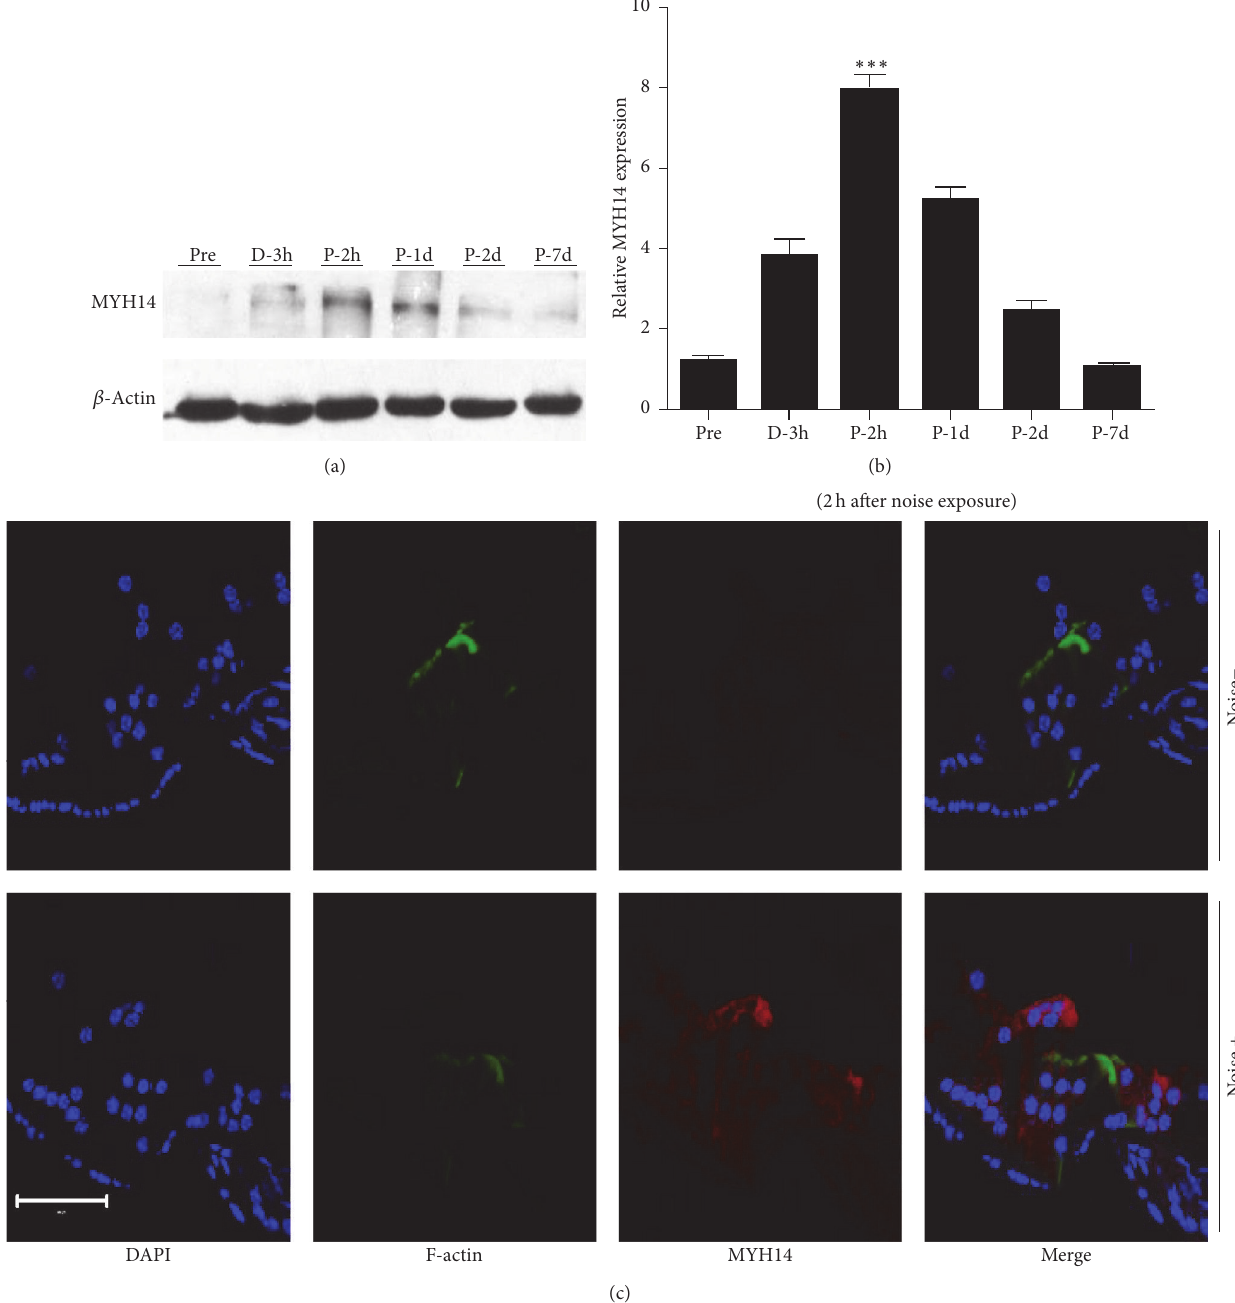
Figure 7: Expression of MYH14 is noise exposure-dependent. ((a) and (b)) Western blots analysis was performed at different time points (before, during, and after noise exposure) to show the expression levels of MYH14 ( 𝑛 = 3 for each group). The expression of MYH14 reached its highest peak 2 h after noise exposure (P-2h) and then gradually returned to basal levels (P-7d). ∗∗∗ 𝑃 < 0.001 by Student’s 𝑡 -test compared to the pre-noise exposure levels. (c) Confocal images showing the expression of MYH14 before and 2 h after noise exposure in the organ of Corti. The organ of Corti was labeled with Alexa 488-conjugated phalloidin (green); red, MYH14; blue, DAPI. Scale bar, 50 𝜇